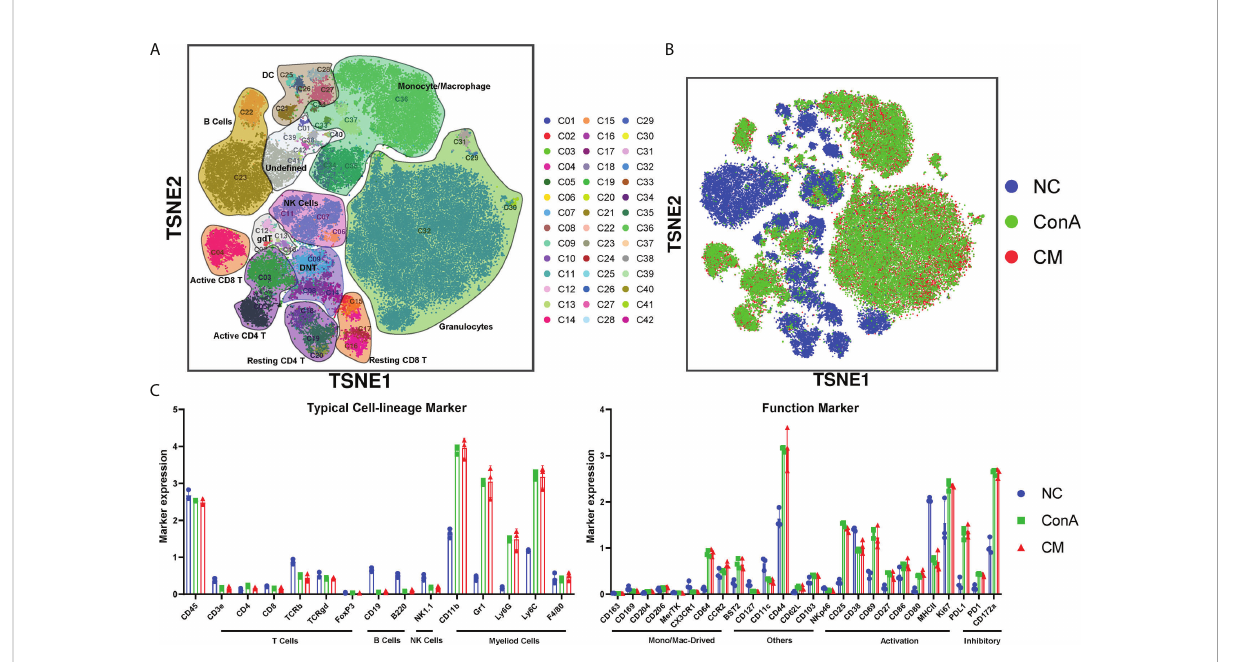
FIGURE 2 Overview of the CyTOF landscape of immune cells in liver samples. (A) t-SNE map colored by different subgroups. (B) t-SNE map colored by three groups. (C) Histograms displaying cell surface marker expression of typical cell lineage markers and functional markers, separately. Data are presented as mean ±